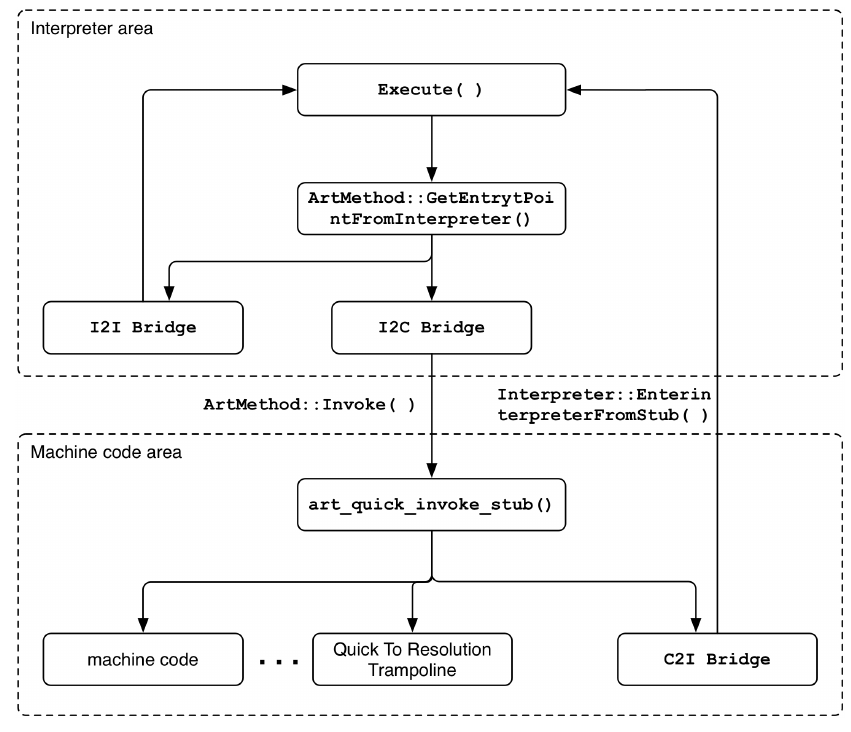
Figure 3. Execution switching between Interpreter region and machine code